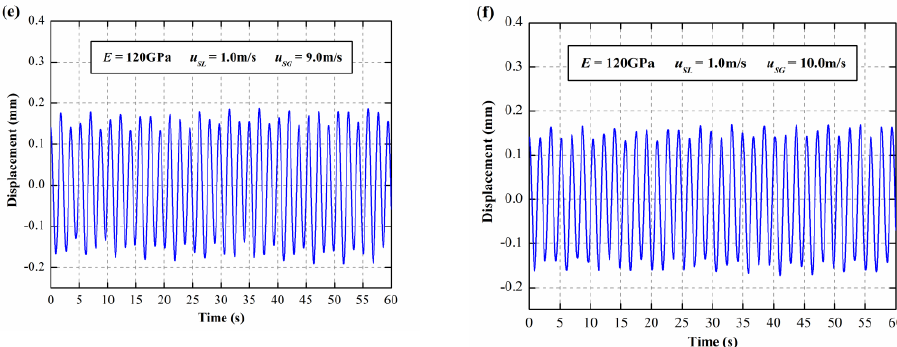
Figure 9. Midpoint displacement of the piping system for E = 120 GPa and u SL = 1.0 m/s (( a ): u SG = 3.0 m/s; ( b ): u SG = 5.0 m/s; ( c ): u SG = 7.0 m/s; ( d ): u SG = 8.0 m/s; ( e ): u SG = 9.0 m/s; ( f ): u SG = 10.0 m/s).